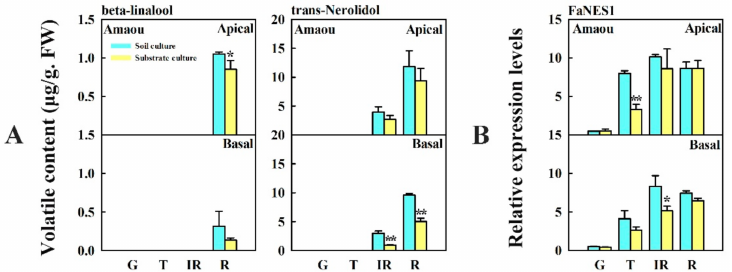
Figure 4. Changes in contents of beta-linalool and trans-Nerolidol ( A ) and expression of FaNES1 ( B ) in ‘Amaou’ strawberry fruits. Bars stand for means ± SD from three biological replicates. Asterisks indicate significant differences (* 0.01 < p < 0.05; ** p <